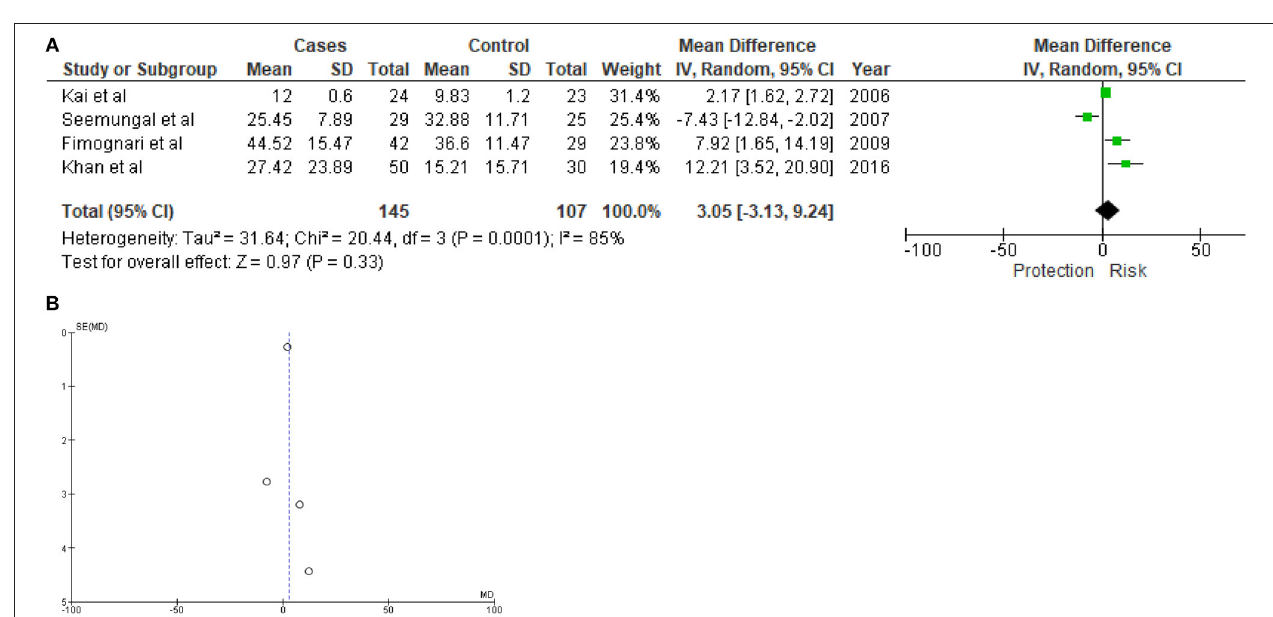
FIGURE 2 | Forest plot (A) and funnel plot (B) showing results of meta-analysis. A total of 145 COPD subjects and 107 healthy controls were evaluated.